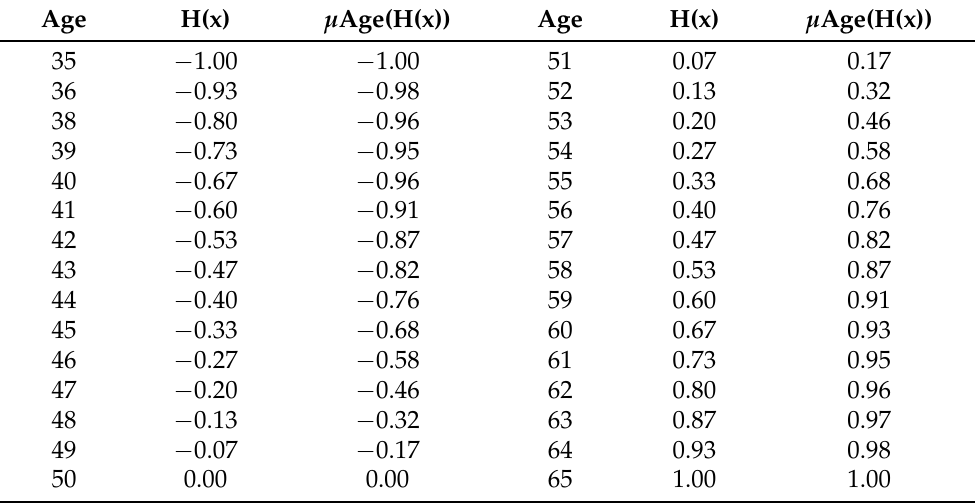
Table 1. Fuzzy characteristic function table for µ